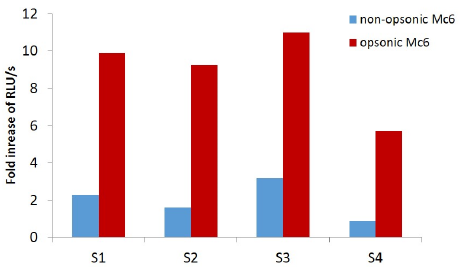
Figure 5. Enzymatic cleavage of surface protein McaP by neutrophil elastase (NE) does not sensitize M. catarrhalis to erythromycin. The curves on activity of erythromycin against WT log phase bacteria pre-treated (1 h, 37 ◦ C) with 2 µ M NE and then incubated for 4 h with antibiotic are shown. Data are expressed as mean cfu/mL ± SD from two independent experiments performed in triplicate.